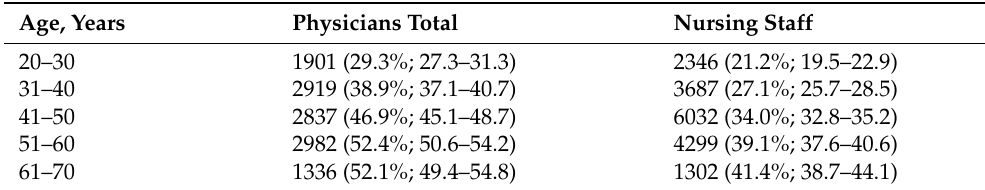
Table A5. Proportion of healthcare workers, ready to be vaccinated against COVID-19 (depending on the age of physicians and nursing